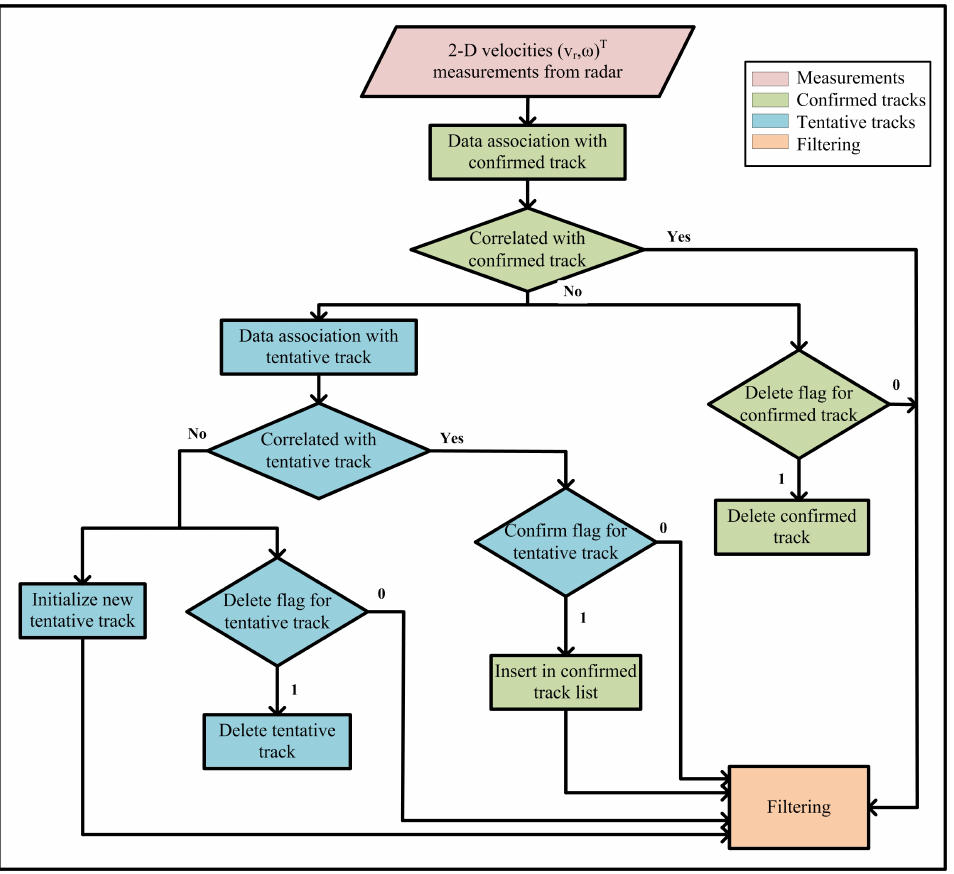
Figure 4. Track management block of multi-target tracker algorithm based on 2-D velocity measure- ment